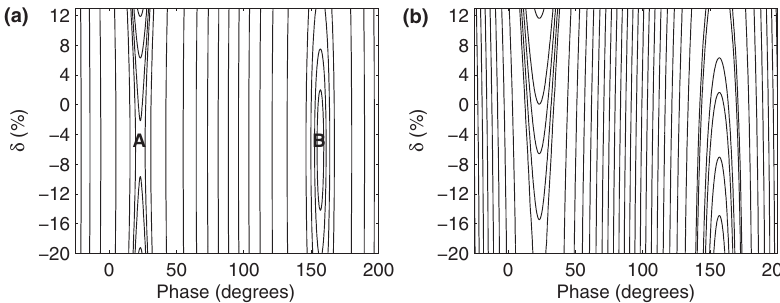
FIG. 3. Impact of the (cid:6) parameter on the longitudinal phase space for very low- (cid:1) optics with (cid:1) 1 ¼ 1 (cid:1) 10 (cid:2) 7 , (cid:1) 2 ¼ 1 (cid:1) 10 (cid:2) 7 assuming (cid:1) 3 ¼ 0 , and (cid:6) ¼ 5 : 5 (cid:1) 10 (cid:2) 9 in (a), (cid:6) ¼ 3 (cid:1) 10 (cid:2) 8 in (b) which correspond respectively to an orbit distortion of (cid:4) 0 : 2 and (cid:4) 1 mm . The fixed points marked by A (unstable) and B (stable) in case (a) are not defined anymore in case